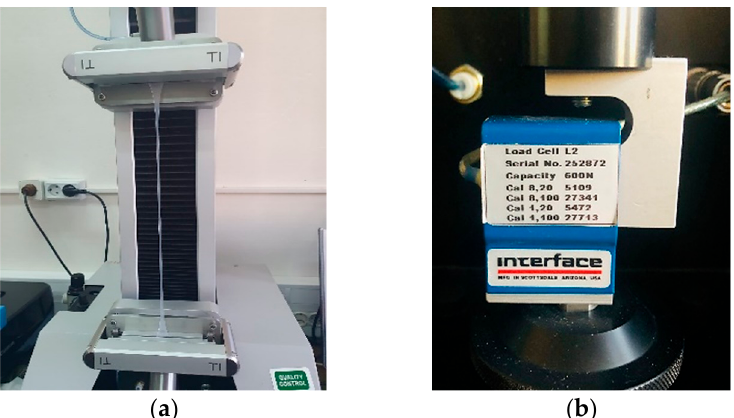
Figure 2. TITAN 2 tensile testing machine, ( a ) Catching specimens in machine jaws, ( b ) 600 N force